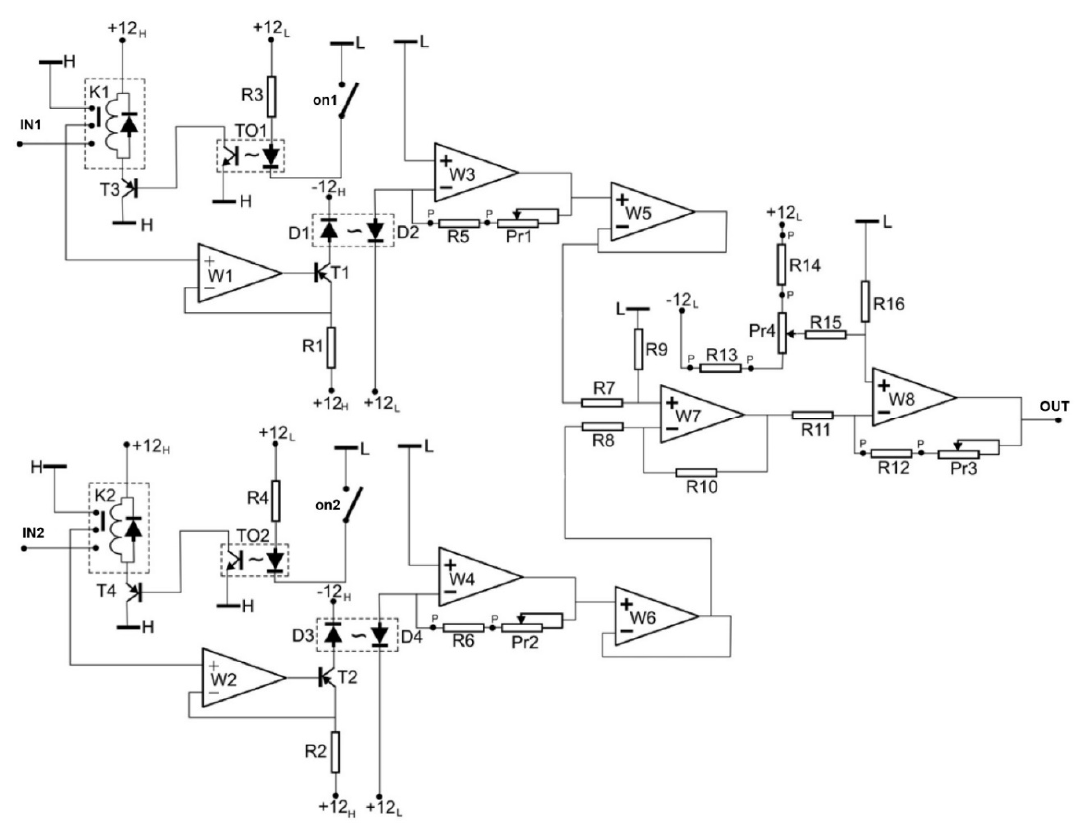
Figure 2. Internal diagram of the opto-isolation circuit designed to ensure high input impedance for measurements of the differential voltage.